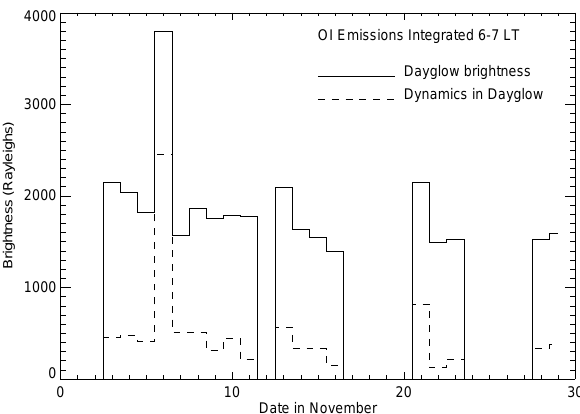
Fig. 5. The average variations of the dayglow brightness (solid line) and the brightness in the dynamical variations (dashed line) dur- ing morning hours for 17 days in the month of November. Notice a factor of 2–3 and 4–5 enhancements in the dayglow brightness and in the dynamical component on the disturbed day (6 November when compared with the average variations on the quiet days of the